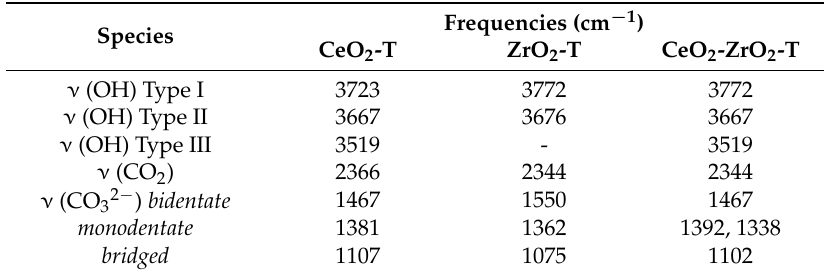
Table 4. Characterization of IR bands of the activated supports.